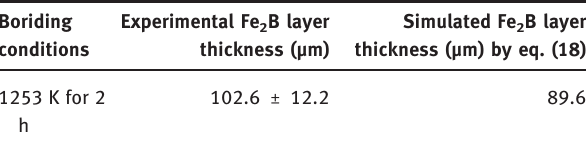
Table 4: Comparison between the experimental value of Fe 2 B layer thickness obtained at 1253 K for 2 h and the predicted value using the integral method for an upper boron content in the Fe 2 B phase equal to 9